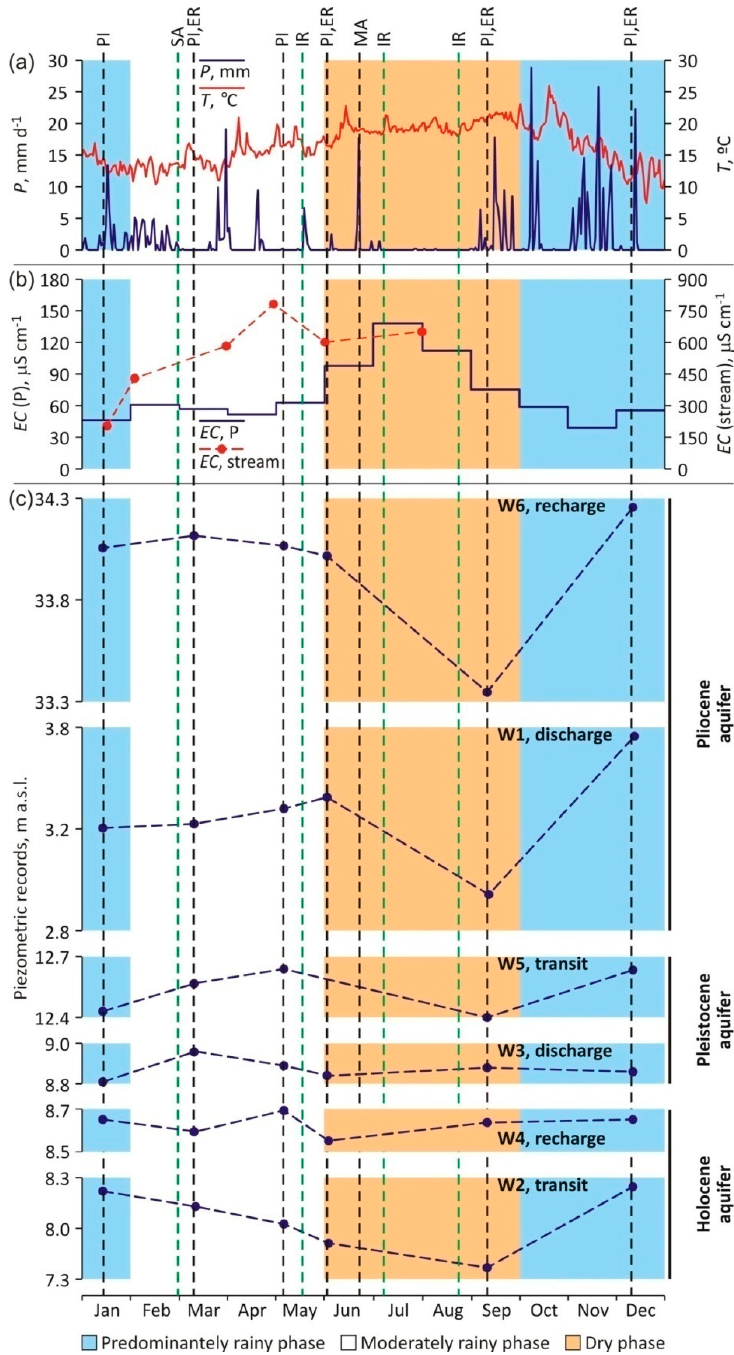
Figure 4. For year 2014 in the SAL area, ( a ) 24-h P and T distribution, after P (mm) and T (°C) records from Sines meteorological station (Figure 1a); ( b ) monthly distribution of average precipitation-weighed EC after EC ( μ S cm − 1 ) and P (mm) records from Monte Velho meteorological station (Figure 1a), and some Cascalheira stream water EC ( μ S cm − 1 ) measurements at site 2 after the SWQM Programme (Figure 1d); and ( c ) piezometry (m a.s.l.) in handmade open wells W1 to W6 (Table 3) ordered according to the monitored geological formation (Pliocene, Pleistocene, Holocene) and groundwater flow zone (recharge, transit, discharge). Vertical black dotted lines indicate geophysical surveying (Table 2) and groundwater monitoring (Table 3) as ERT (ER) and MASW (MA) surveys, and piezometry (PI). Vertical green dotted lines indicate human actions modifying water dynamics as SAL aperture (SA) and groundwater pumping for irrigation (IR).